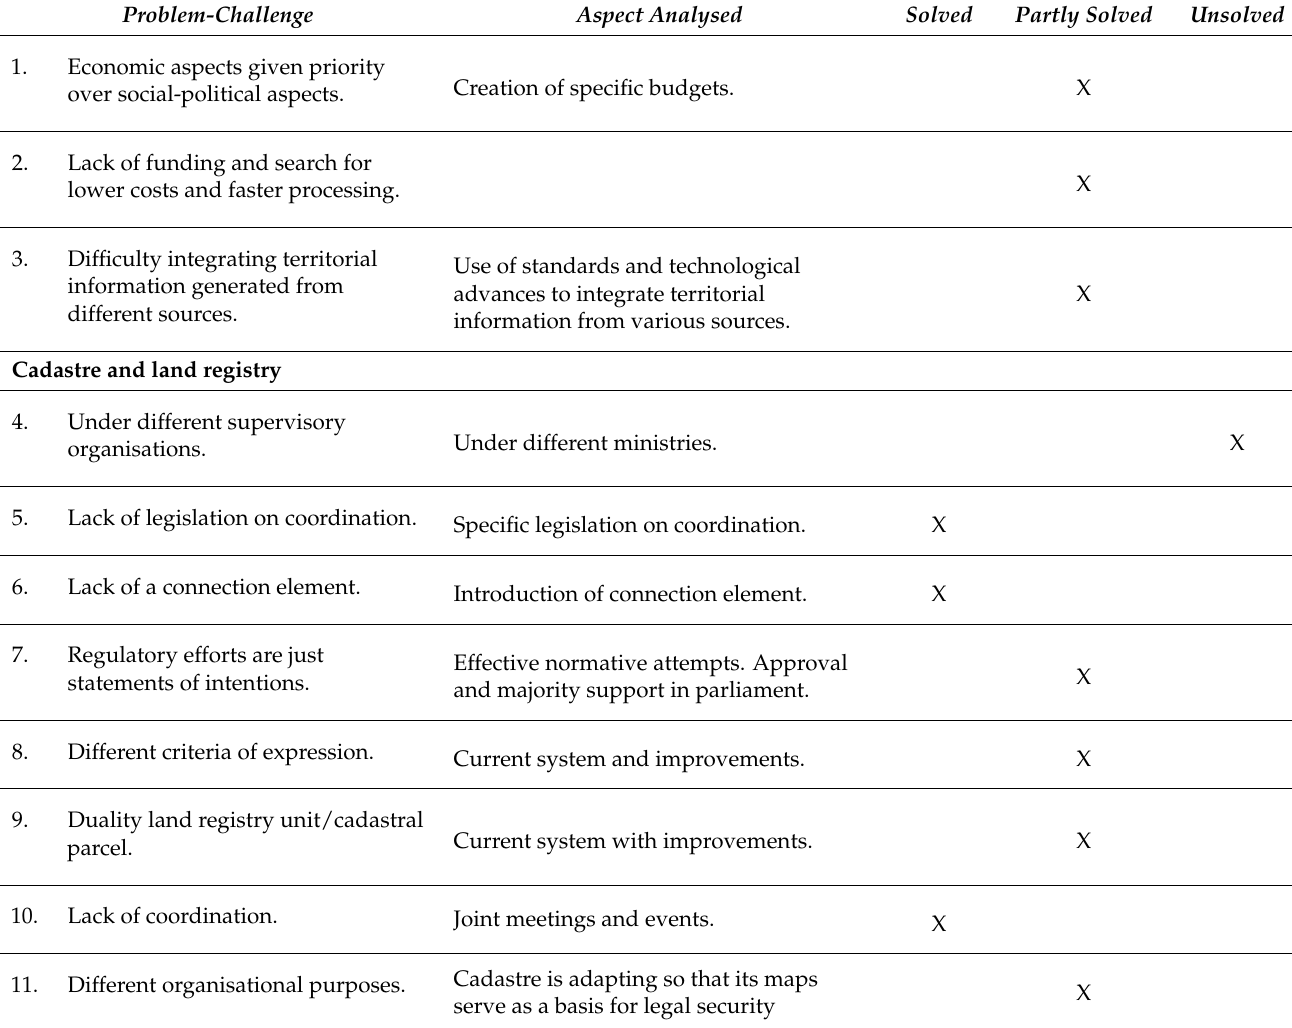
Table 2. General outline of the challenges to be overcome in order to achieve cadastre–land registry coordination in Spain. Source: